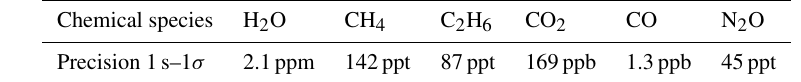
Table 2. Typical 1s–1 σ precision during ground-based instrument checks.